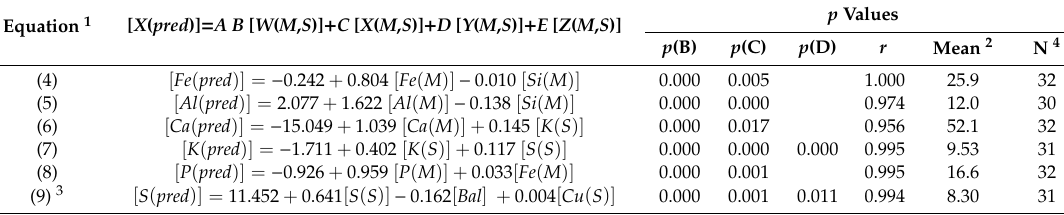
Table 4. Multiple linear equations for the prediction of aqua regia extractable contents of majority metal (X (pred)) from the readings obtained by the PXRF.